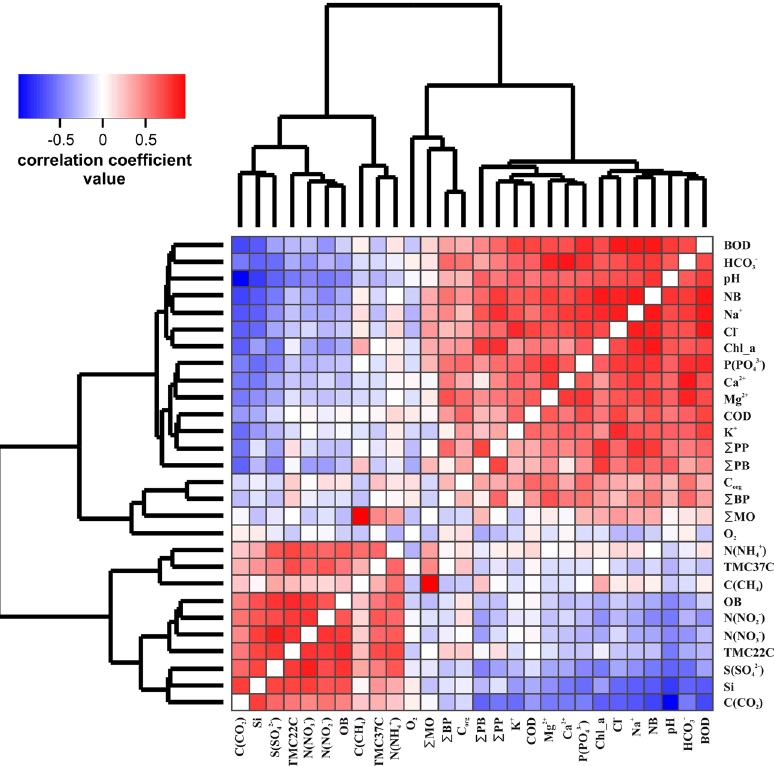
Figure 3. Heat map of pairwise correlation coefficients for biological and hydrochemical parameters. Parameters in the heat map are ordered according to the clustering based on similarity of correlation coefficient vectors. Clusters discussed in text (A, B, C, D) are shown on the clustering